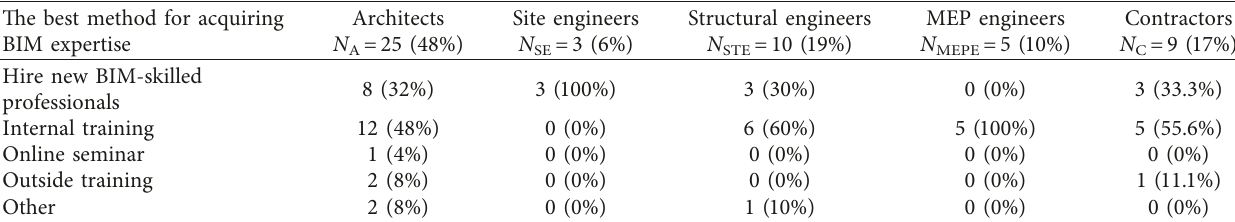
Table 4: Relationship between the role of the respondent and the best method for acquiring BIM expertise. The best method for acquiring